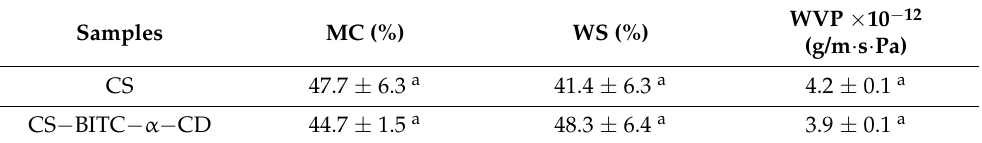
Table 1. Moisture content (MC), water solubility (WS), and water vapor permeability (WVP) of CS and CS − based composite